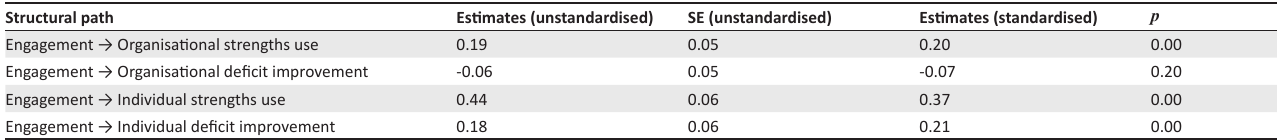
TABLE 2: Estimates ( β ) of the direct structural paths in the standardised model. Structural